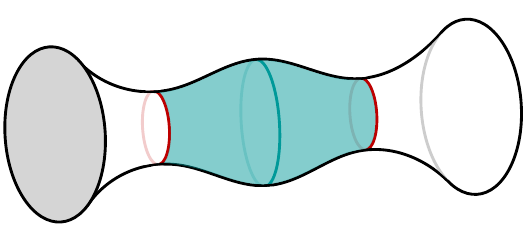
Figure 1 . Schematic sketch of a Python’s Lunch wormhole geometry. The wormhole’s width exhibits two local minima (red), between which is a region (teal shading) where reconstruction using boundary data on either side of the wormhole alone is obstructed. This is because once a local minimum exists in the bulk geometry homologous to an entire boundary, no minimal surface anchored to that boundary can probe past the local minimum, thus precluding any sort of bulk reconstruction that relies on boundary-anchored extremal objects, such as in ref. [15]. Another way of seeing this di(cid:14)culty in the context of operator reconstruction is through the greedy algorithm reconstruction of ref. [16]; attempting to push an operator in the bulging region outward results in the algorithm becoming trapped at the